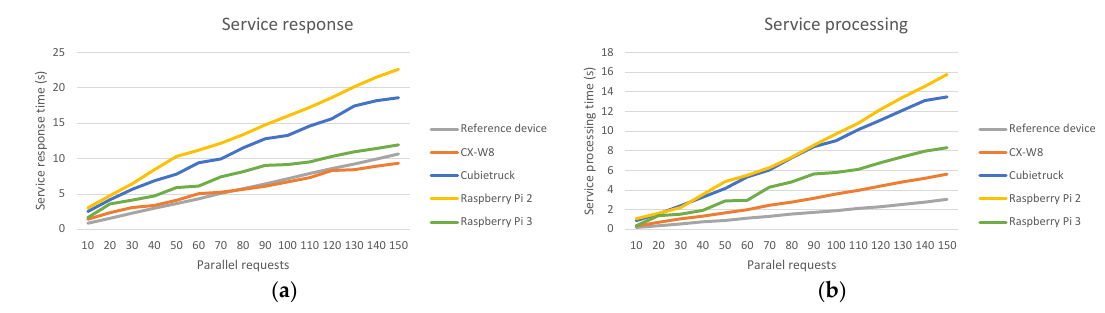
Figure 11. ( a ) Response; and ( b ) processing times of service consumption.